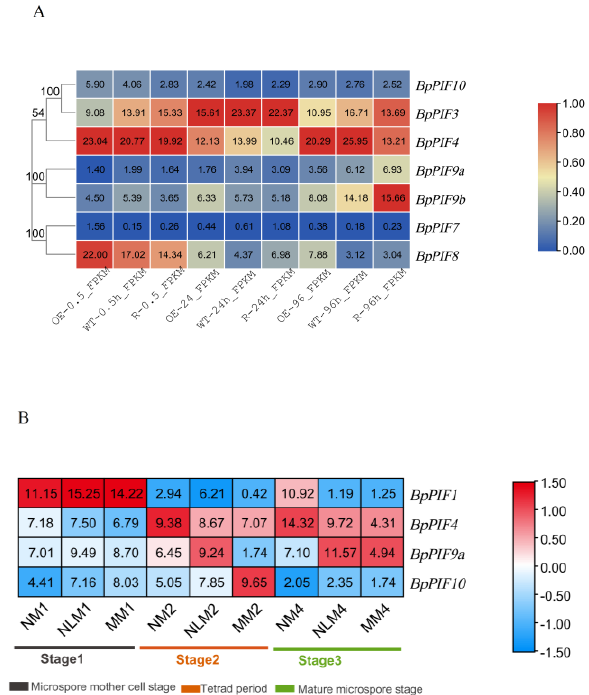
Figure 6. Heatmap of the expression profiles of BpPIF family genes ( A ) The developmental expression pattern analysis of BpPIF family genes at three developmental stages during rooting induction. The 0.5, 24, and 96 represent 0.5, 24, and 96 h after cutting shoots cultivating in WPM medium; OE-, R-, and WT- represent overexpression lines, suppressed expression lines and wild-type birch, respectively. Clustering was based on log2-transformed FPKM values of seven BpPIF genes. ( B ) Expression pattern analysis of four family genes in fertile male flowers and sterile male flowers in different developmental stages of birch. The expression data were acquired from the RNA-seq data with three biological replicates. Values shown on the heatmaps represent the average FPKM value of three biological replicates.